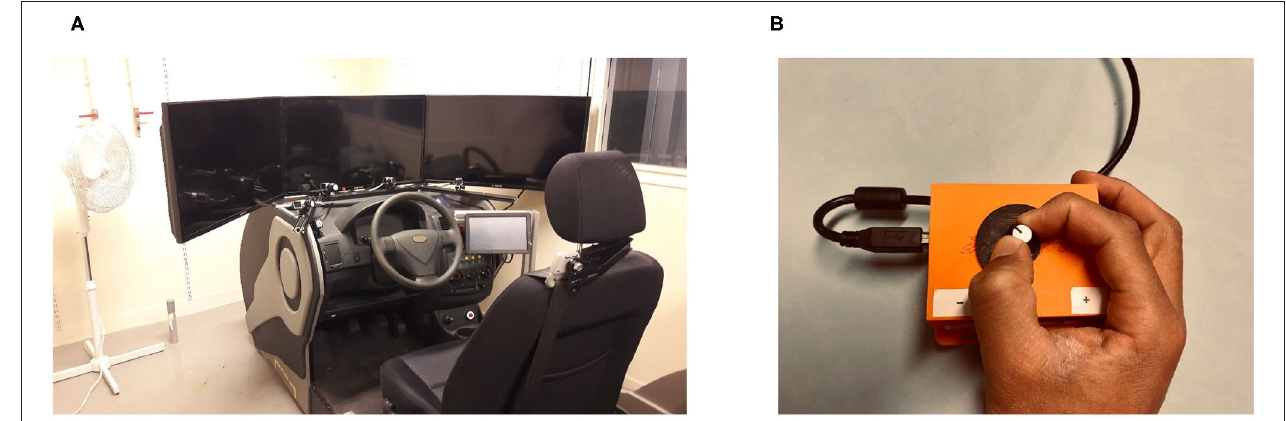
FIGURE 3 | Experimental setup. (A) A fixed-base driving simulator. (B) Analogue device for subjective risk